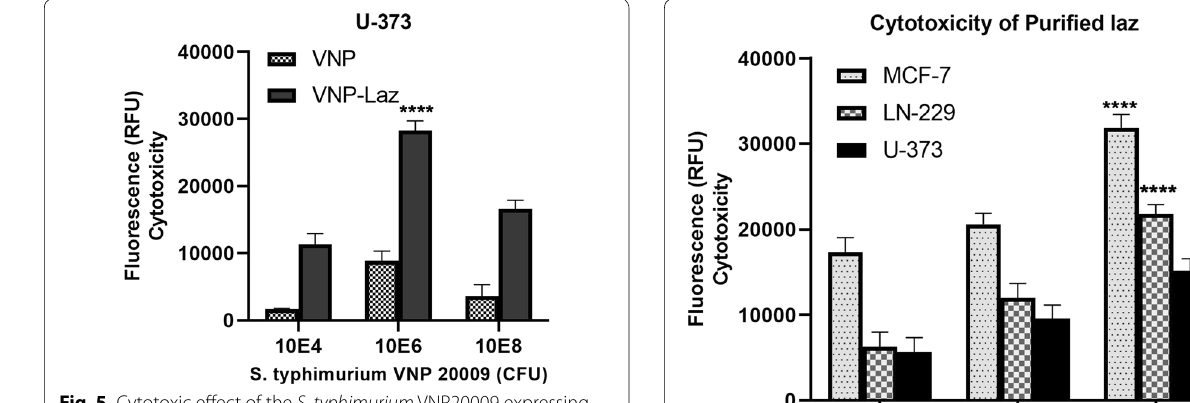
Fig. 5 Cytotoxic effect of the S . typhimurium VNP20009 expressing Laz (VNP‑Laz) on tumor cells in vitro. Monolayers glioblastoma cell line U‑373 (carrying a mutated p53) were co‑cultured with VNP alone, or VNP‑Laz using the same bacterial densities mentioned Fig. 6 Cytotoxic effect of the purified Laz on tumor cells in vitro. above, under hypoxic conditions for 24 h. Apoptosis was assessed as Monolayer of MCF‑7 Breast cancer cell line and glioblastoma cell lines mentioned above. All data are shown as mean s.e.m and represent ± U‑373 and LN‑229 were incubated with increasing concentrations data from three independent experiments n 3. *P < 0.0001 with = (0.1, 1, 5 μg ml − 1 ) of purified Laz protein or a control protein respect to the control groups at the same concentration (Ovalbumin) for 24 h. Apoptotic activity was assessed with respect to the control group at the same concentration *P < a specific number of bacterial adhesion sites available on the surface of the host cell.